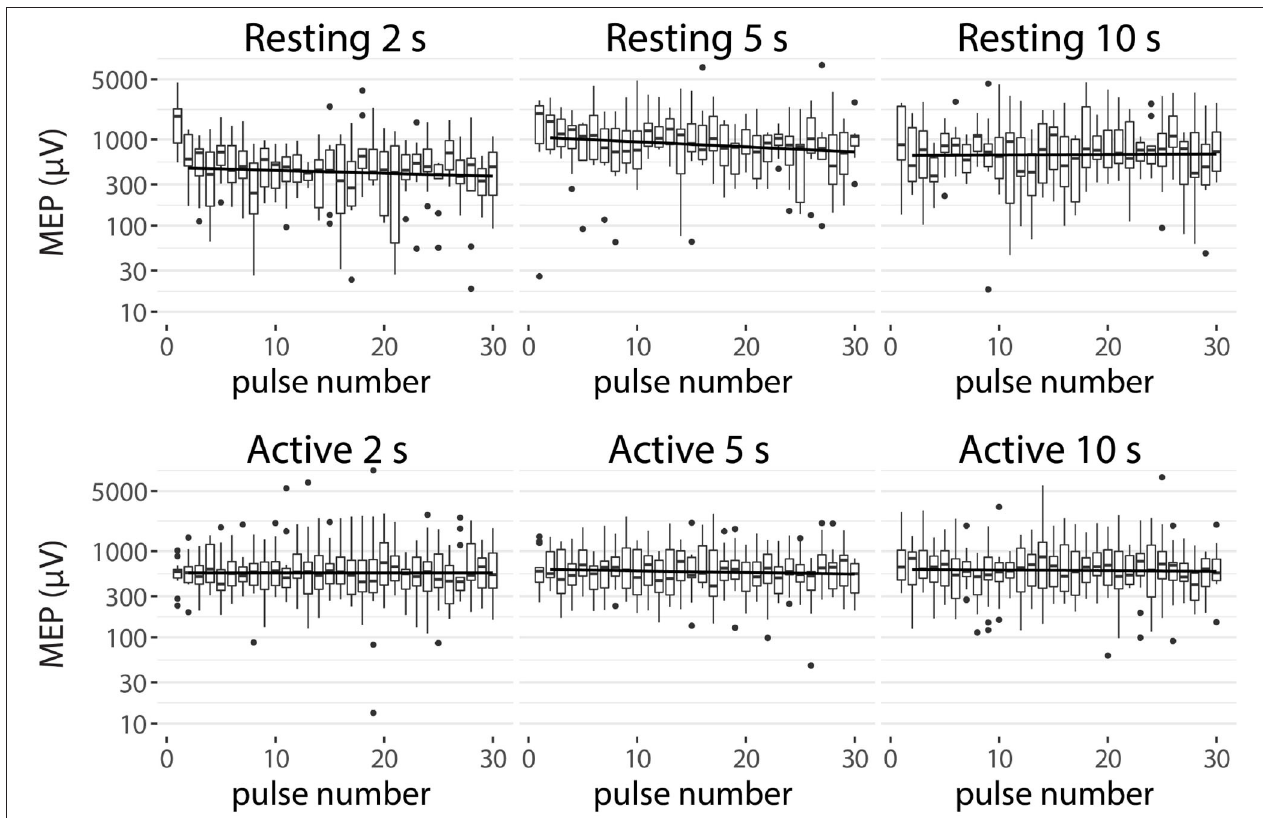
FIGURE 3 | MEP amplitudes of each IPI (2, 5, and 10 s) for resting and active condition. Participant-specific intercepts have been removed from the data using a linear mixed effects model. Graphs represent the minimum, maximum, median, first quartile, and third quartile in the data set on a logarithmic scale. The trend line is drawn from the second to the last